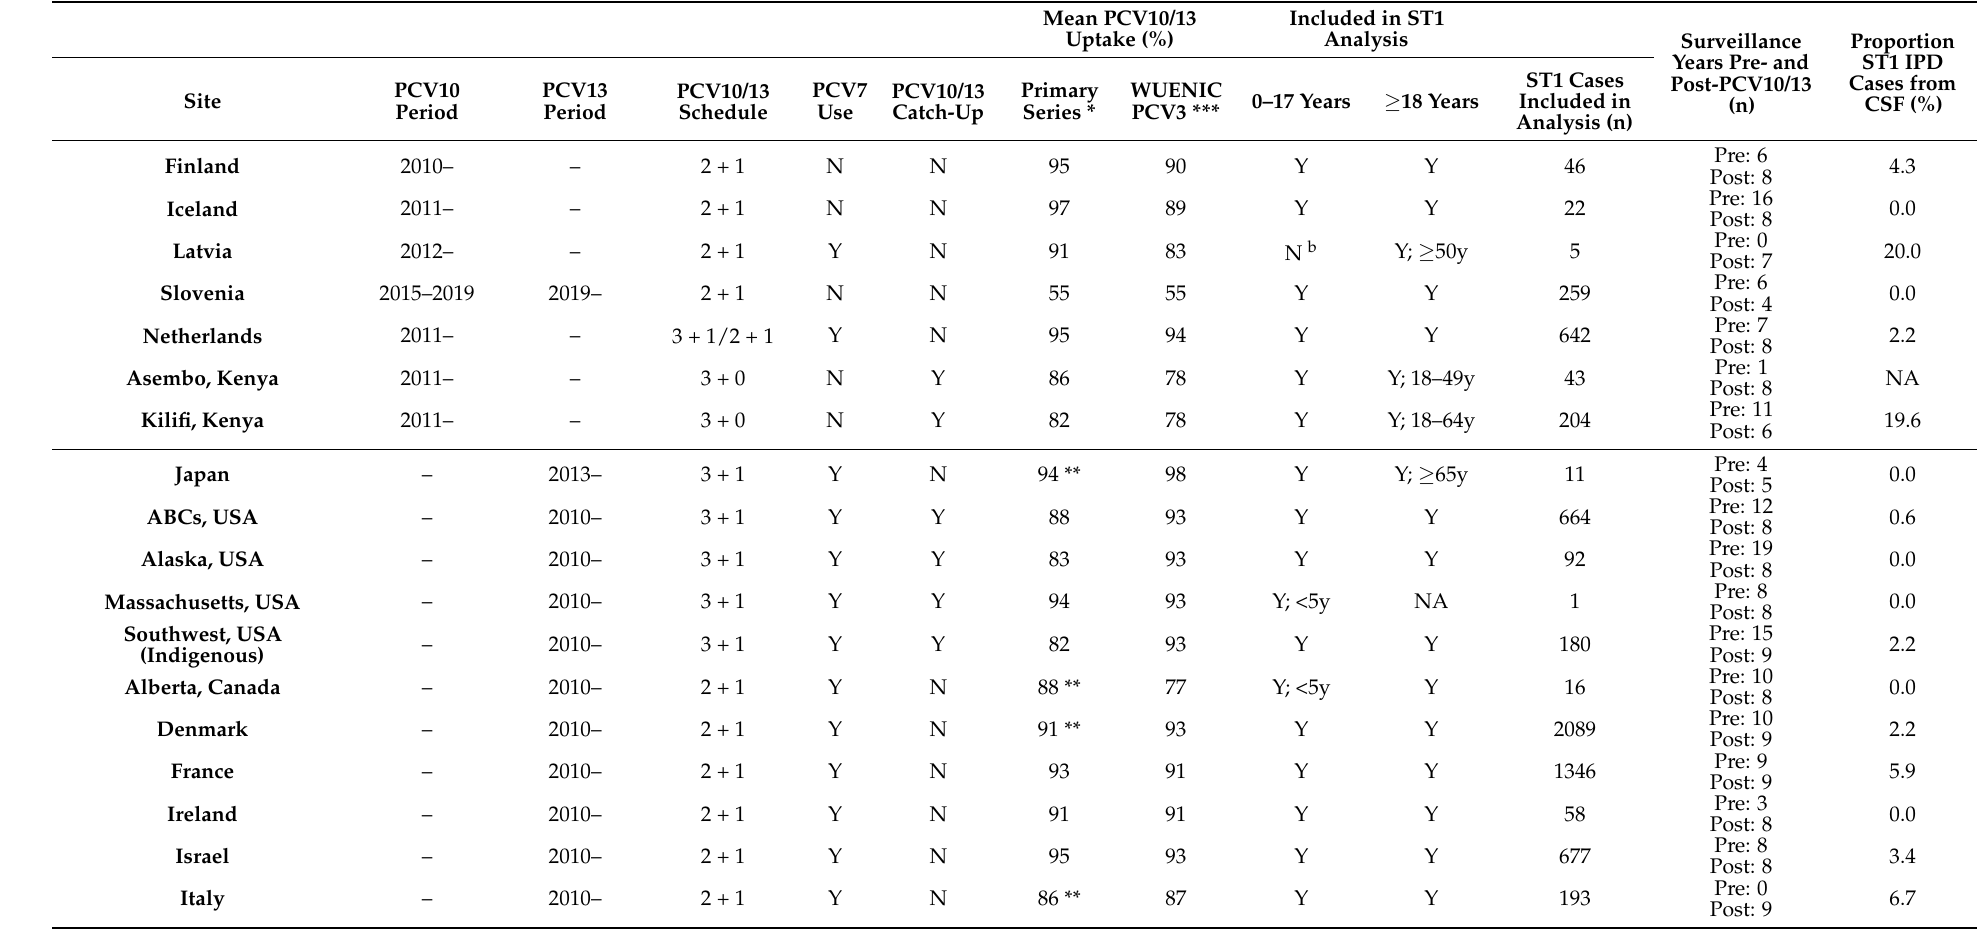
Table 1. Description of infant pneumococcal conjugate vaccine program and surveillance data for included sites. Ordered by vaccine product and